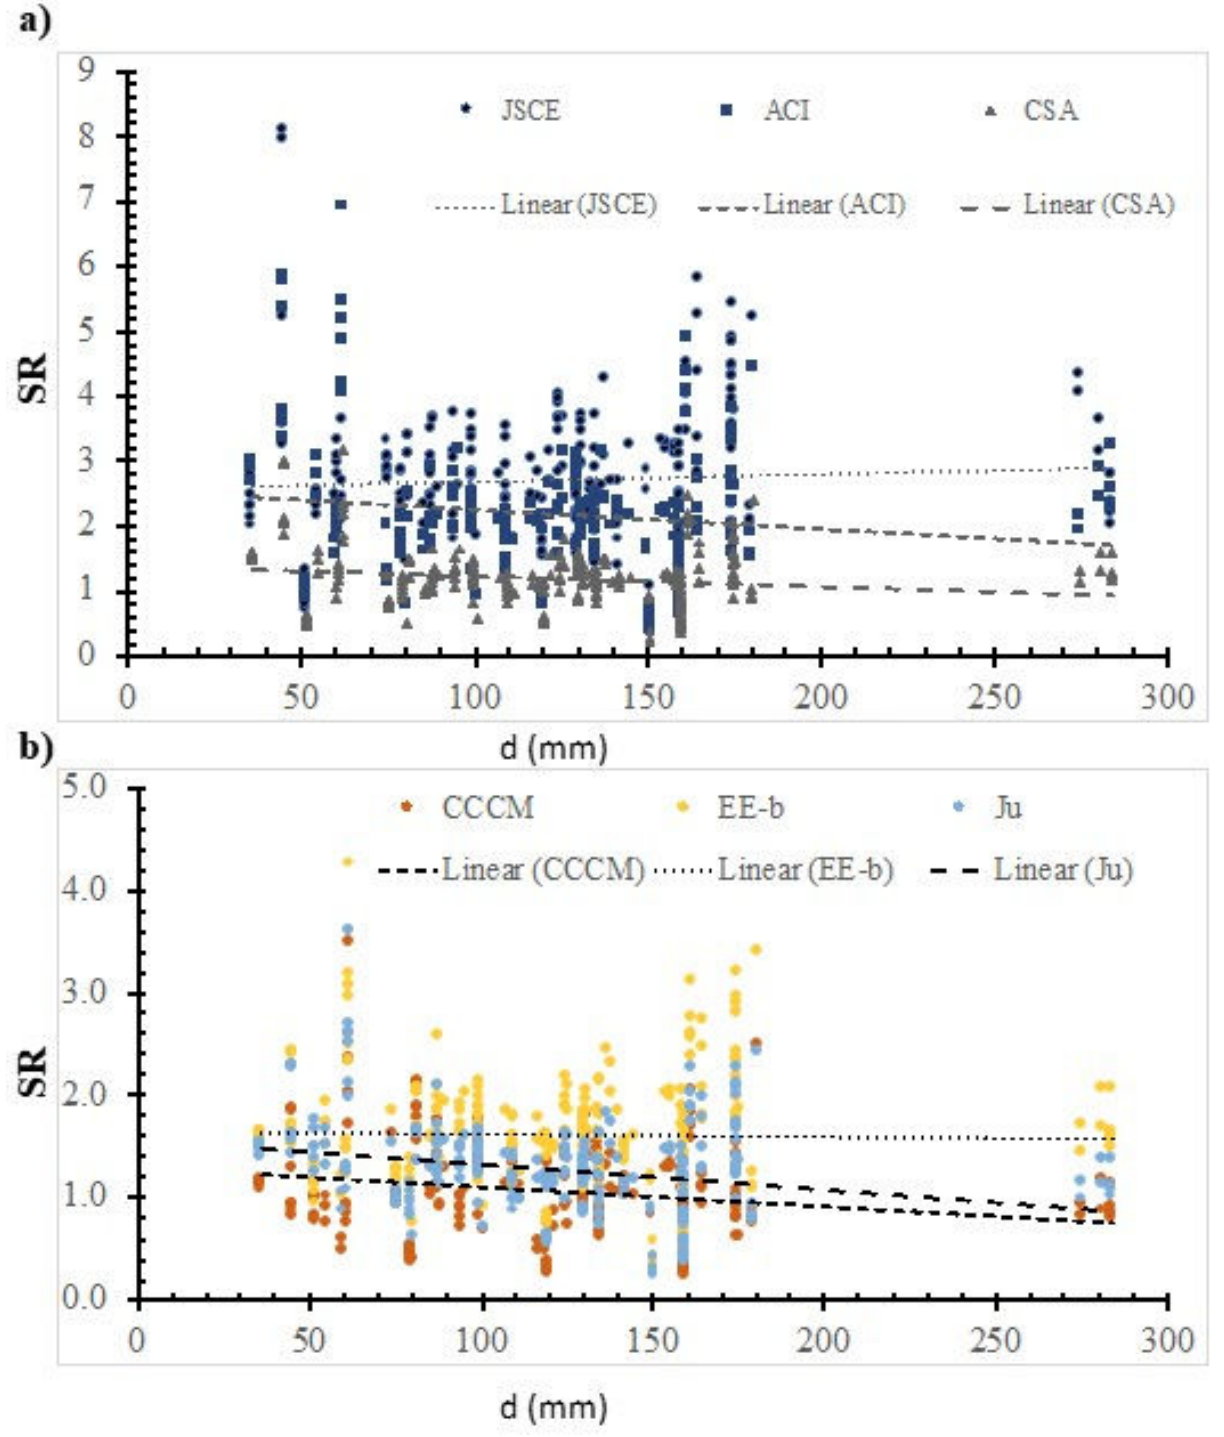
Figure 6. The effect of depth on the SR value, calculated using selected models. ( a ) Design codes; ( b )